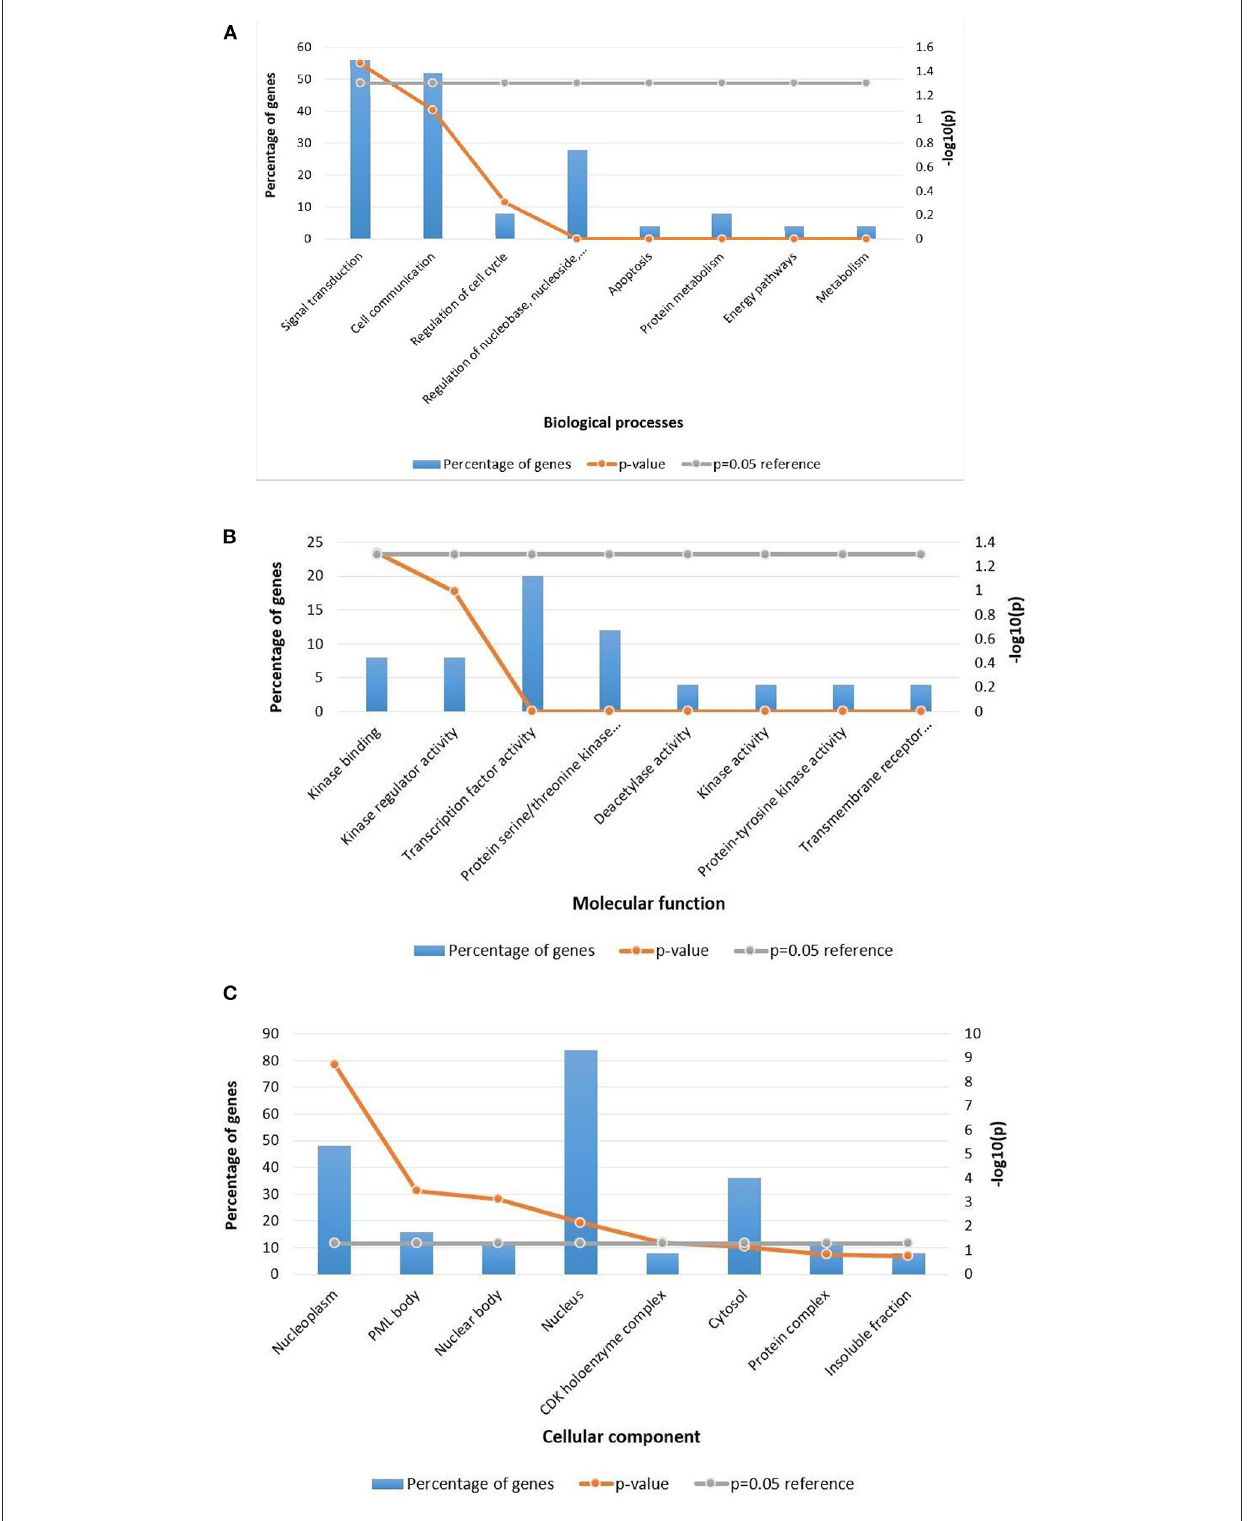
FIGURE3 Functional enrichment analysis of Osteosarcoma gene. Significantly enriched (A) Biological processes, (B) Molecular function, (C) Cellular component. The p -value is taken as 0.05 for